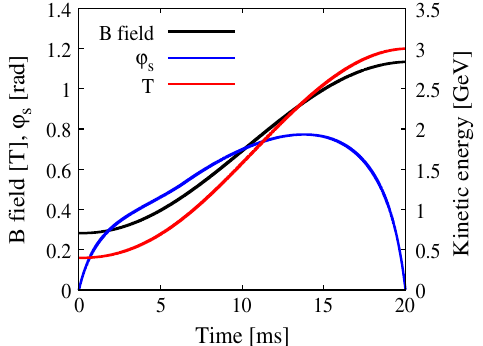
FIG. 4. Sinusoidal B field pattern of bending magnets, the corresponding kinetic energy of the beam, and the change in the synchronous phase as functions of time. Time-dependent changes in many parameters, including error sources, and kicker imped- ances are implemented in the present ORBIT simulations.